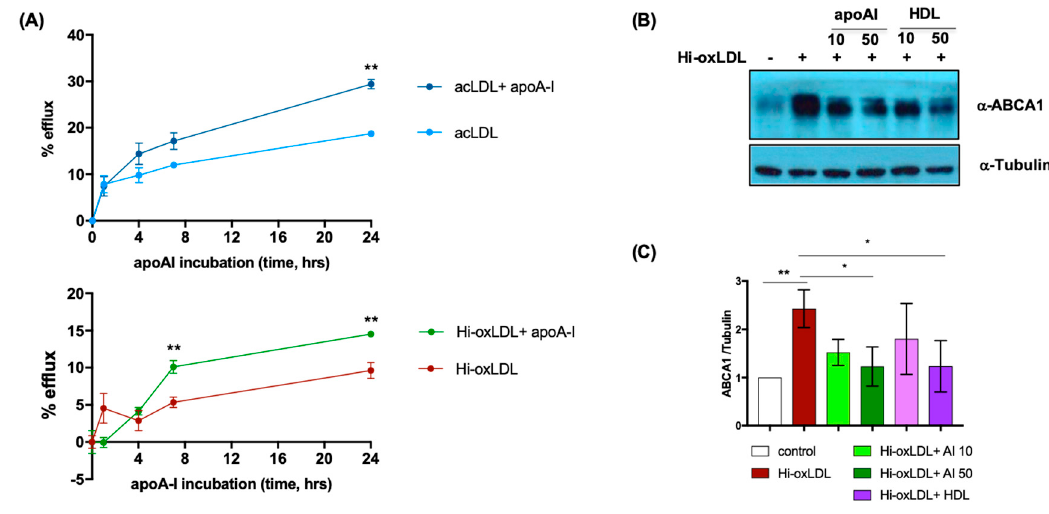
Figure 2. ApoA-I increases efflux of free cholesterol (FC) from hi-oxLDL-loaded foam cells. ( A ) MPMs were loaded with 3 H-cholesterol-coupled acLDL or hi-oxLDL. Cholesterol efflux was initiated with 50 μ g/mL of apoA-I. The cells without apoA-I loading were used as a control. The net percentage of cholesterol efflux at each time point compared to time 0 was presented as % efflux ( n = 4 per each treatment). ( B , C ) Hi-oxLDL-loaded MPMs were loaded with 10 or 50 μ g/mL of apoA-I or HDL. Immunoblotting with anti-ABCA1 and anti-tubulin were performed, and the relative level of ABCA1 was normalized with tubulin and quantified ( n = 3) using Fiji software. The data for both cholesterol efflux and WB were presented as mean ± SEM. * p < 0.05, ** p < 0.005.